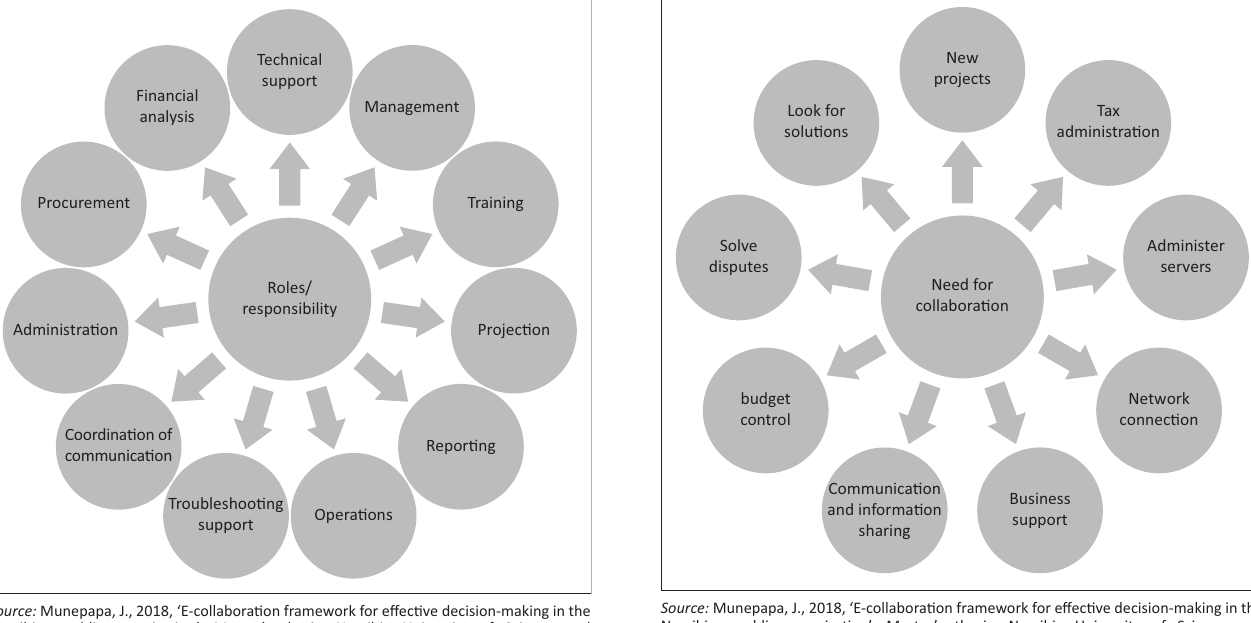
FIGURE 3: Context and need for collaboration within the